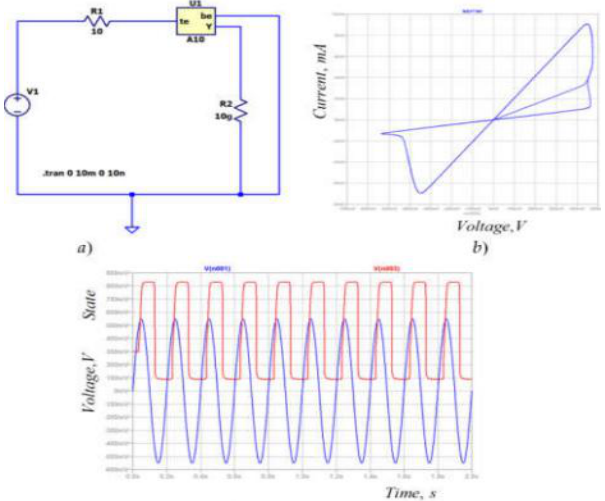
Figure 17. A simple circuit for testing the memristor model and corresponding current–voltage characteristics